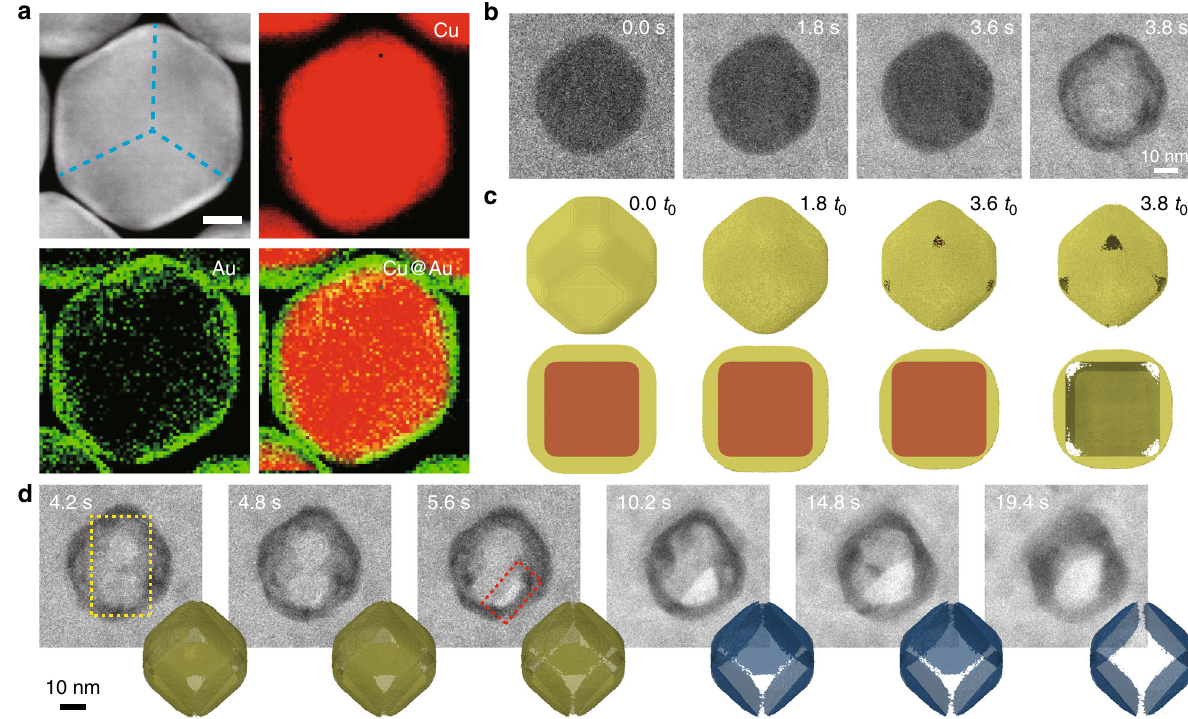
Fig. 6 Nanobox intermediate during dissolution of truncated Cu@Au nanocube. a STEM-HAADF image and STEM-EELS elemental maps of a Cu@Au nanocube (44.3-nm Cu core and 2.6-nm Au shell). Scale bar: 10 nm. b , c Time-lapse TEM images b and corresponding simulation snapshots c extracted from Supplementary Movies 10a and 11 showing rapid dissolution of the Cu core of a truncated Cu@Au nanocube yielding a thin-shell nanobox. Cut-section snapshots in the bottom row reveals rapid dissolution of the Cu core upon exposure to the oxidative environment while dissolution of Au shell is negligible. Chemical potential in simulation: − 3.525 eV. d Time-lapse TEM images extracted from Supplementary Movie 10a showing etching of the Au shell upon continued electron beam irradiation and corresponding Monte Carlo simulation snapshot drawn by rendering nanocrystal shape with transparency. The last three snapshots (blue color) are not derived from simulation but drawn to illustrate the three-dimensional